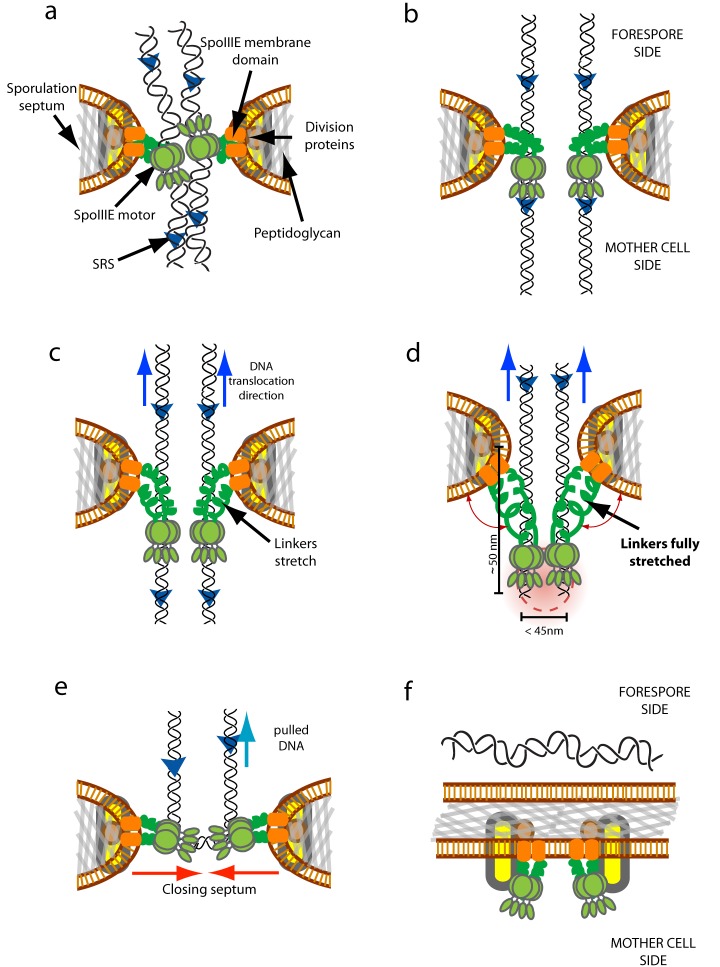
Model for the establishment and architecture of the DNA-translocating SpoIIIE complex.(a) SpoIIIE motors are recruited to the center of constricting sporulation septa and bind nonspecifically to DNA. Early divisional proteins interact with SpoIIIE membrane domains and contribute to the formation and regulation of the aqueous channel. (b) Interactions between SpoIIIE-γ and SRS lead to the establishment of directional motion towards the mother cell compartment. (c–d) The movement of SpoIIIE motors on DNA continues until the linker domains are fully stretched, at which point further translocation by SpoIIIE causes directional chromosomal segregation. Red gradient represents the size of a PALM-limited cluster. (e) Upon completion of DNA translocation, SpoIIIE motors disengage from DNA and the last segment of circular DNA is pulled into the forespore. (f) After completion of DNA translocation, SpoIIIE or a protein interacting with it leads to membrane fission.